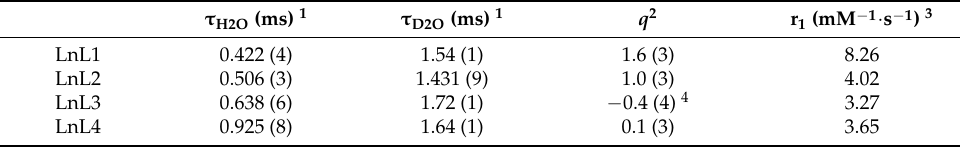
Table 1. Eu 3+ luminescence lifetime measurements (pH/pD = 7.4; λ exc = 396 nm and λ em = 616 nm), calculated inner sphere hydration numbers, and relaxivity values of the GdL complexes (pH 7.5, 25 ◦ C and 20